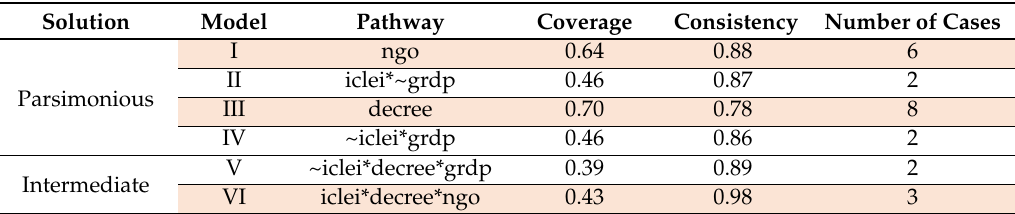
Table 5. Pathways for solar PV